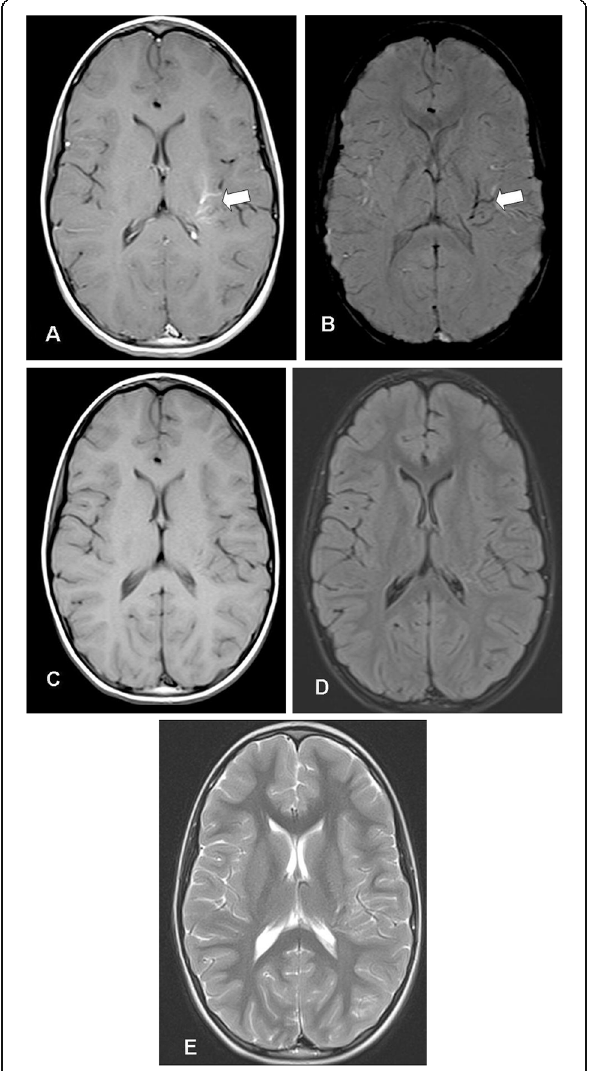
left temporal lobe (arrow). On non-contrast T1W ( c ), FLAIR ( d ), and T2W ( e ), there is no definite abnormality at the